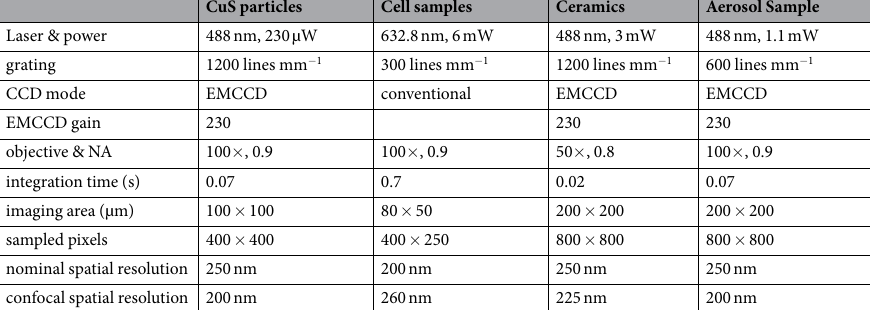
Table 1. Experimental parameters for Raman imaging of the different